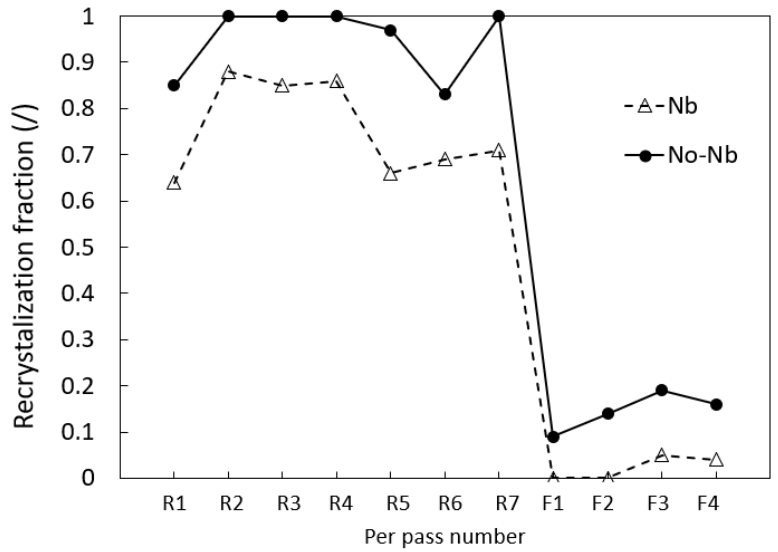
Figure 2. Recrystallization fraction of both compositions (0 Nb, 240 Nb) based on low-temperature slab reheating regime. Both compositions are predicted with incomplete recrystallization in the roughing stage whereas the lowest SRX is achieved with 240 Nb.